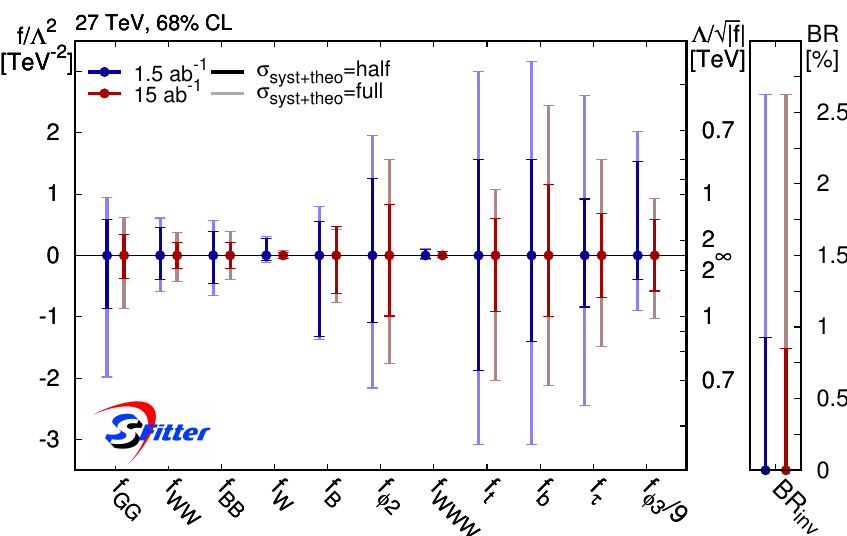
Figure 2: Result from the global Higgs analysis in terms of dimension-6